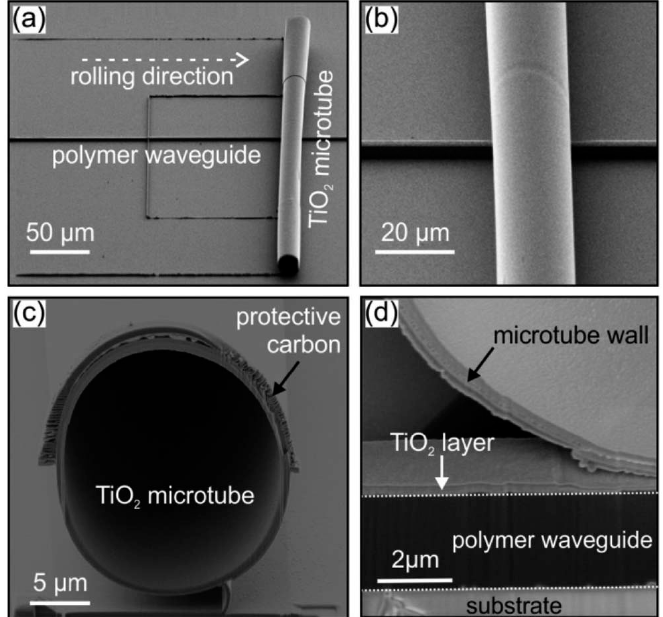
Figure 8. Lab-in-a-tube system made of rolled-up TiO 2 microresonators integrated with polymer waveguides. ( a ) Microtube was rolled-up by a U-shaped pattern. ( b ) Close-up view of the tube that is connected tightly with the polymer waveguide to ensure optimal optical coupling. ( c ) Compact winding layers of the tube wall were revealed by a FIB cut with the protection of a carbon layer. ( d ) The FIB cut image at the waveguide revealed the compact tube wall in the vicinity of the polymer waveguide [101].